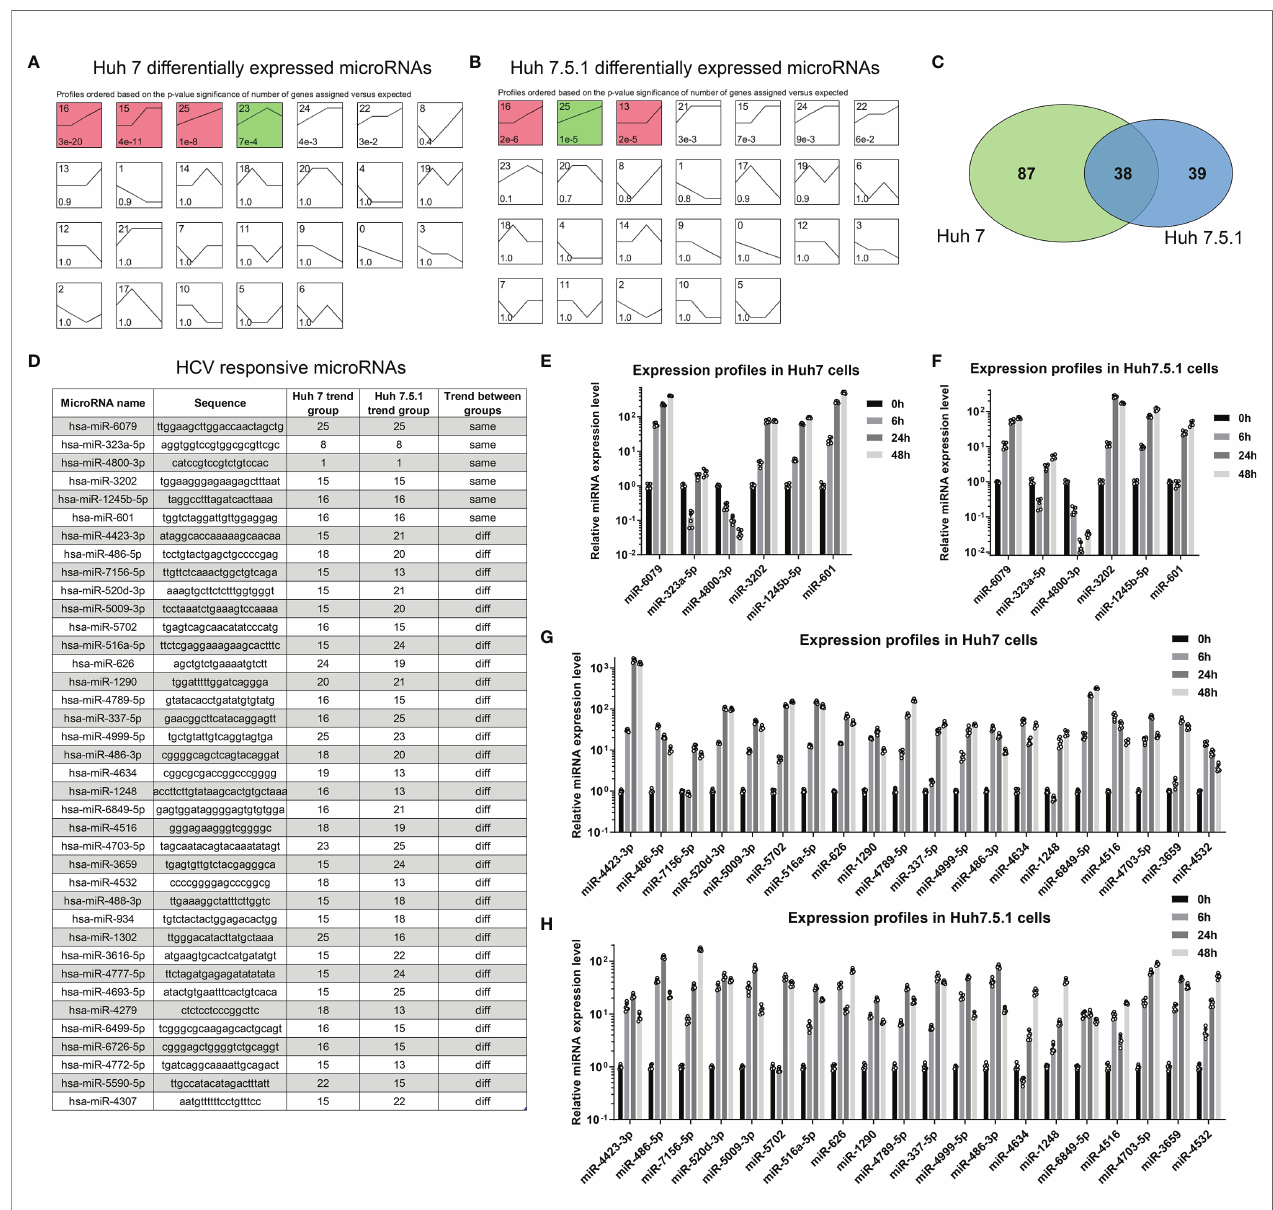
FIGURE 2 | miRNA signatures were different between Huh7 and Huh7.5.1 cells. (A, B) miRNA expression changes were categorized using series cluster method, and was classi fi ed into 26 different expression pattern groups in Huh7 and Huh7.5.1 cells. (C) Venn plot showing the differentially expressed miRNAs in both cell lines. (D) The sequences of HCV responsive miRNAs in Huh7 or Huh7.5.1 cells were illustrated, and their change pro fi les were identi fi ed to check whether they are in the same or different trend groups. The expression of the 6 miRNAs in the same group was evaluated in HCV infected Huh7 (E) and Huh7.5.1 cells (F) . The expression of the 20 miRNAs in the different group was also checked in HCV infected Huh7 (G) and Huh7.5.1 cells (H)